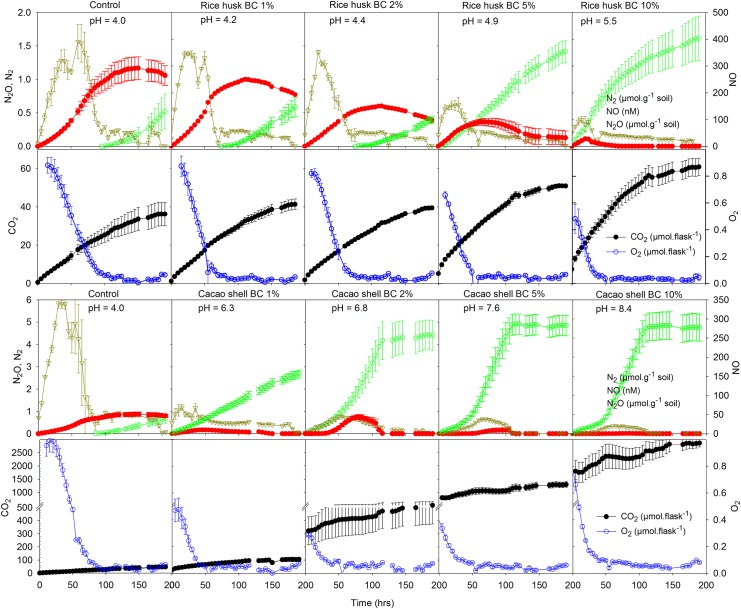
Denitrification kinetics and CO2 and O2 concentrations in anoxic incubations of Lampung soil amended with increasing doses of untreated rice husk BC (upper 2 panels) and cacao shell BC (lower 2 panels).Shown are averages of three incubations; error bars denote SE. Approximately 6.1 μmol NO3
--N g-1 was added to 9.8 g soil in the bottles. Note the differences in the scale of y-axis.